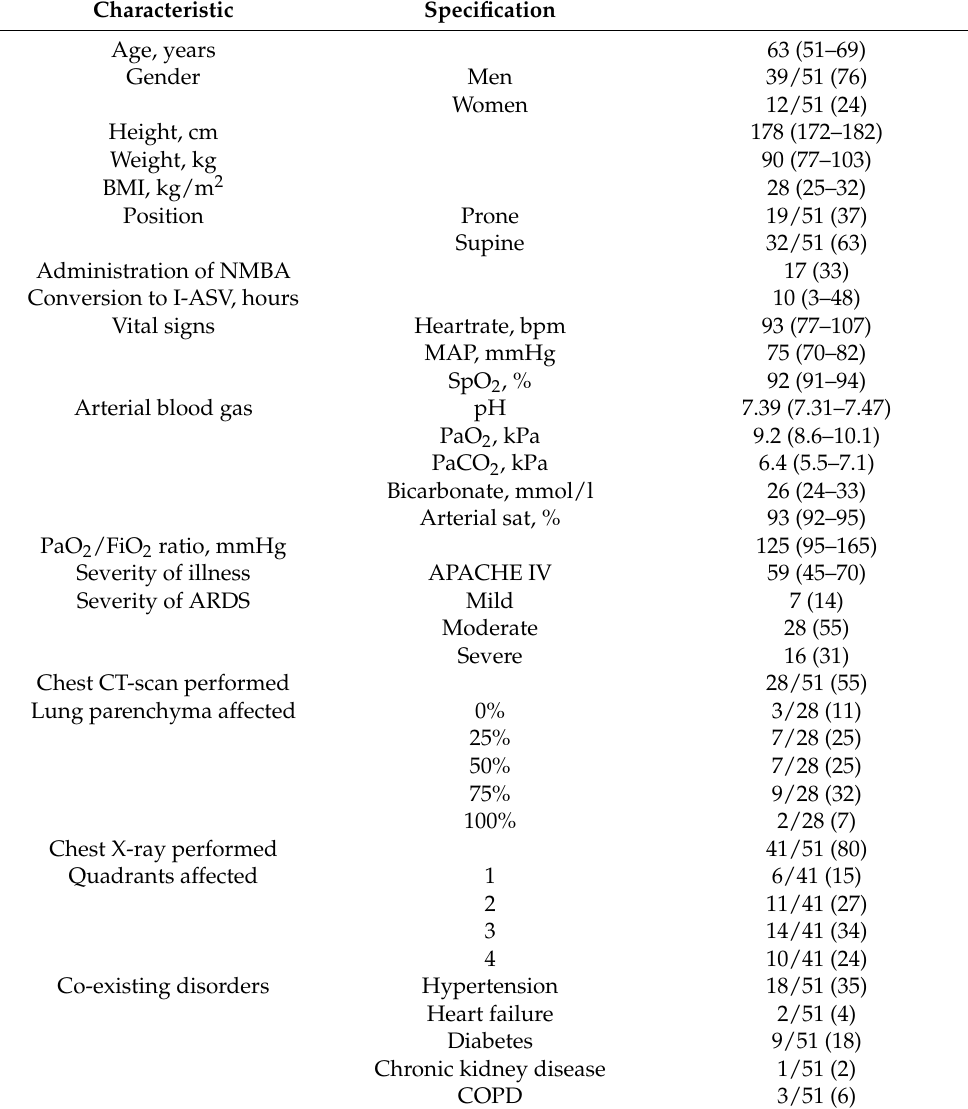
Table 2. Baseline